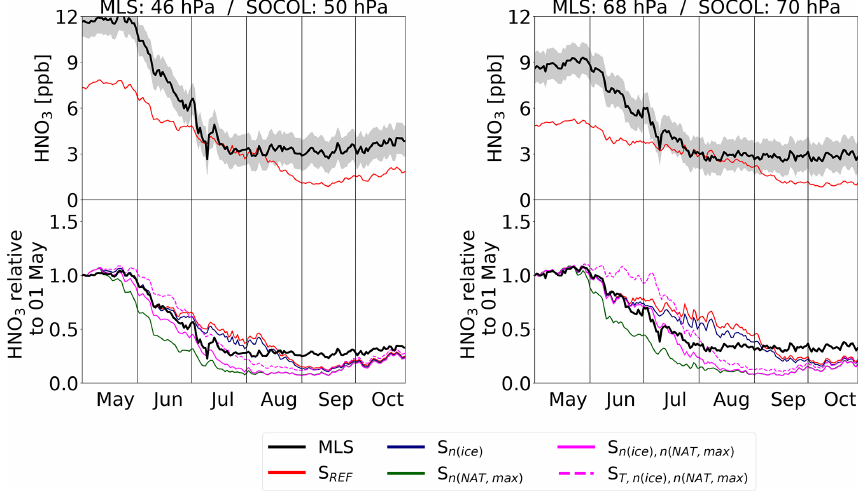
Figure A9. As Fig. 7, but for the year 2006.